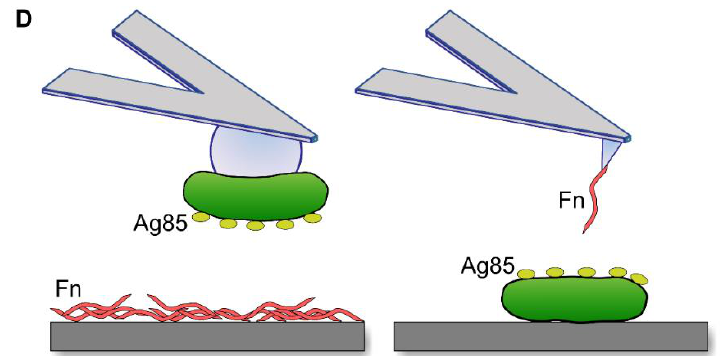
Figure 1. Mycomembrane-associated Ag85 is used by M. abscessus to bind Fn. ( A ) Secreted Ag85 is associated with the mycomembrane, which it helps produce via its mycolyltransferase activity and, where it is exposed on the bacterial surface to participate in adhesin-ligand interactions. ( B ) M. abscessus cells (pointed out by black arrows) attached to Fn-coated substrates (left panel), while bacterial attachment was inhibited by the addition of both Fn pep (top right panel) and Ag85 pep (bottom right panel). At least 10 images for each condition from two independent experiments showed similar results. ( C ) Smooth surface topology observed for whole M. abscessus rough (R) variant cells by contact mode imaging (top left, 3D-projection of height data; bottom left, vertical deflection image) and 300 × 300 nm zoom 3rd degree-polynomial flattened height image (right panel) taken on top of one cell (green squares in the left panels indicate where the zoom was performed). Data representative of 29 images. ( D ) Cartoons depicting, on the left, the single-cell force spectroscopy and on the right, the single-molecule force spectroscopy approaches followed to study molecular force interactions between Ag85 and Fn.